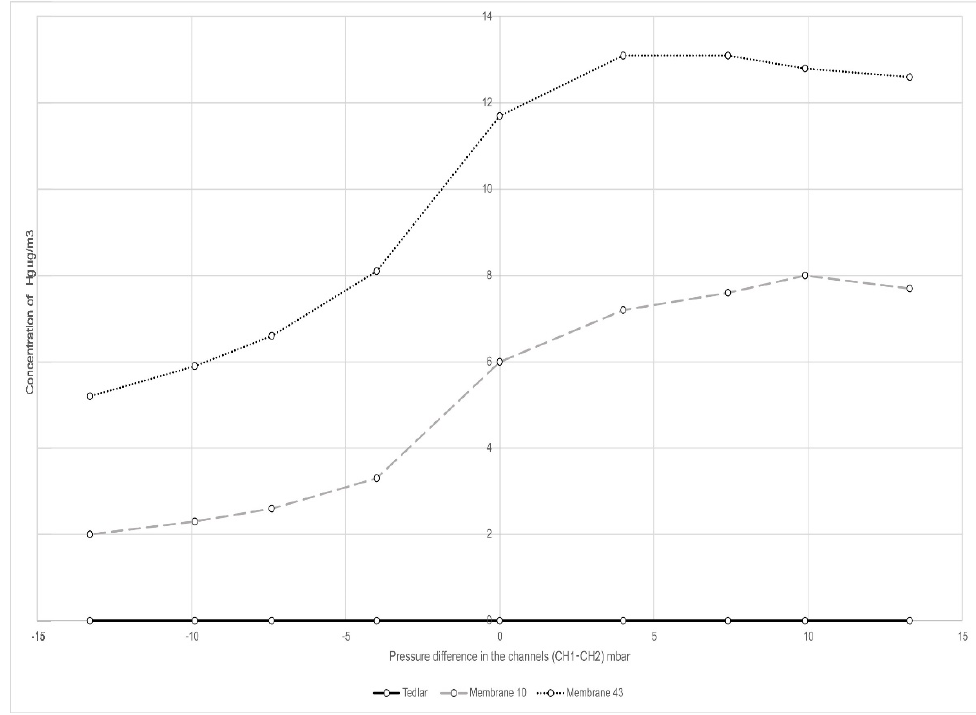
Figure 10. Dependence of mercury concentration in the CH2 channel on the pressure difference between the